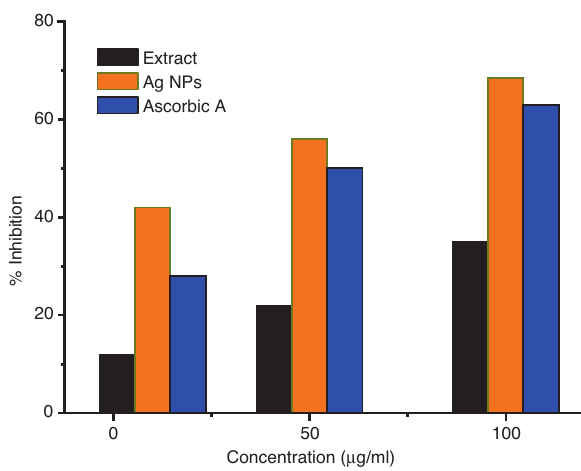
Figure 8: DPPH RSA of M. polymorpha leaf extract and synthesized AgNPs.